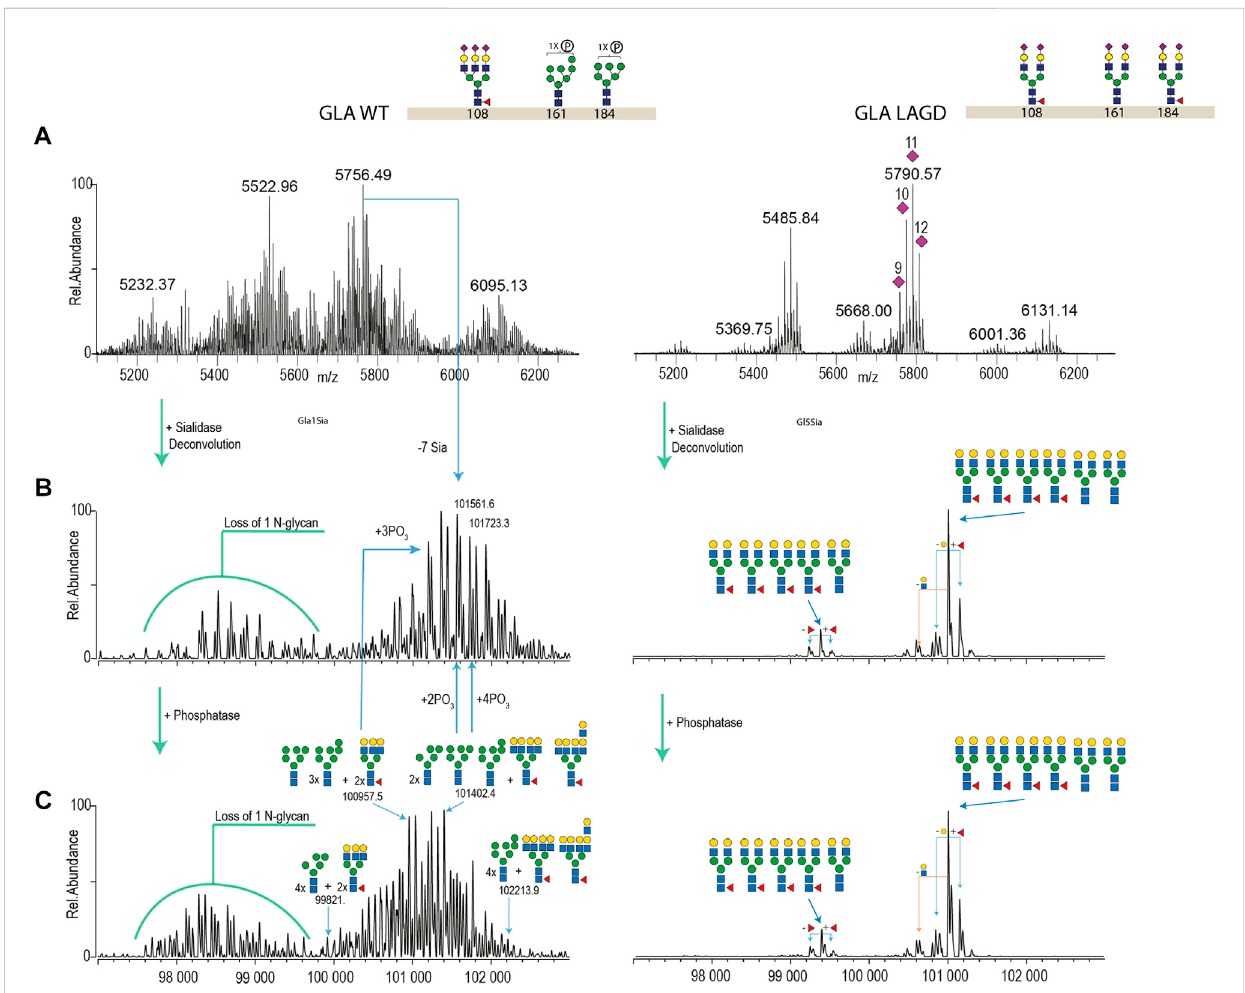
FIGURE 4 IntactMSanalysisofGLAWT/glycodesignatthenativeconditionsandaftersialidaseandphosphatasetreatment.Mostabundantglycanstructuresat N-glycosites(Asn108,Asn161,andAsn184)ofGLAWTandGLALAGDareillustratednexttotheenzymename.MassdeconvolutedspectraofGLAWTand GLALAGDareshownontheleftandrightsides,respectively.Panel (A) showsnativespectrawithpurplediamondsdenotingthetotalnumberofsialicacid residues, as validated by sialidase treatment. Panel (B) shows deconvoluted spectra of sialidase treated enzyme, while Panel (C) shows that of sialidase and phosphatase treated